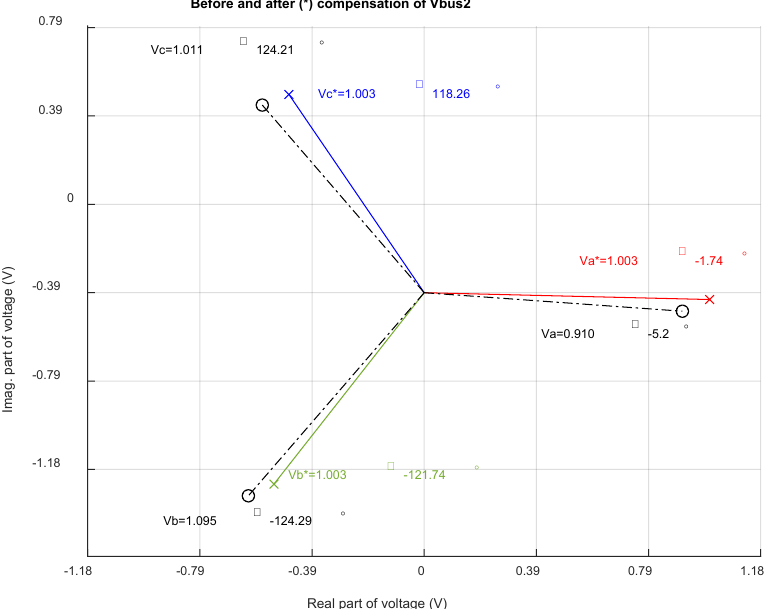
Figure 3. Voltage phasors at Bus 2 with/without compensation by the circuit analysis method. Table 2. Power flow with compensation by the circuit analysis method in Case